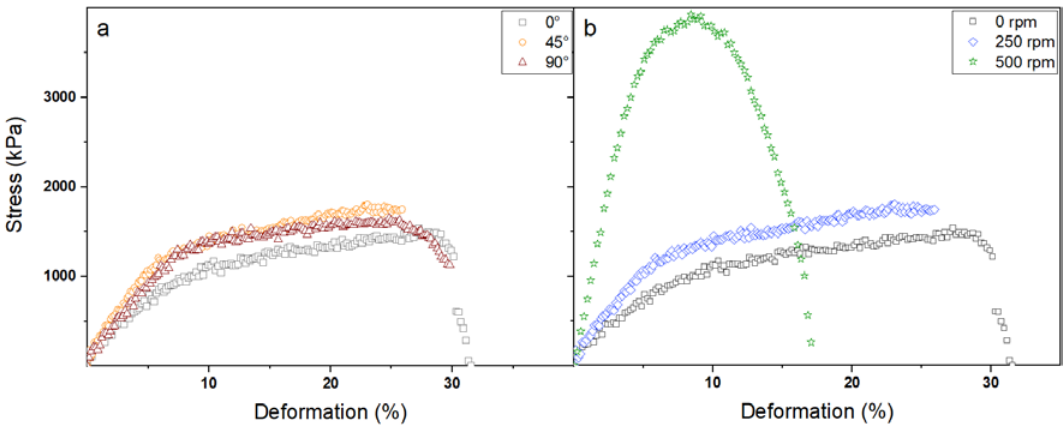
Figure 3. Stress-deformation curves for PVP membranes obtained with the same collector rotating speeds (i.e., 0 rpm) in different directions ( a ) and for PVP membranes obtained with different collector rotating speed in the same direction (i.e., 0°) ( b ).